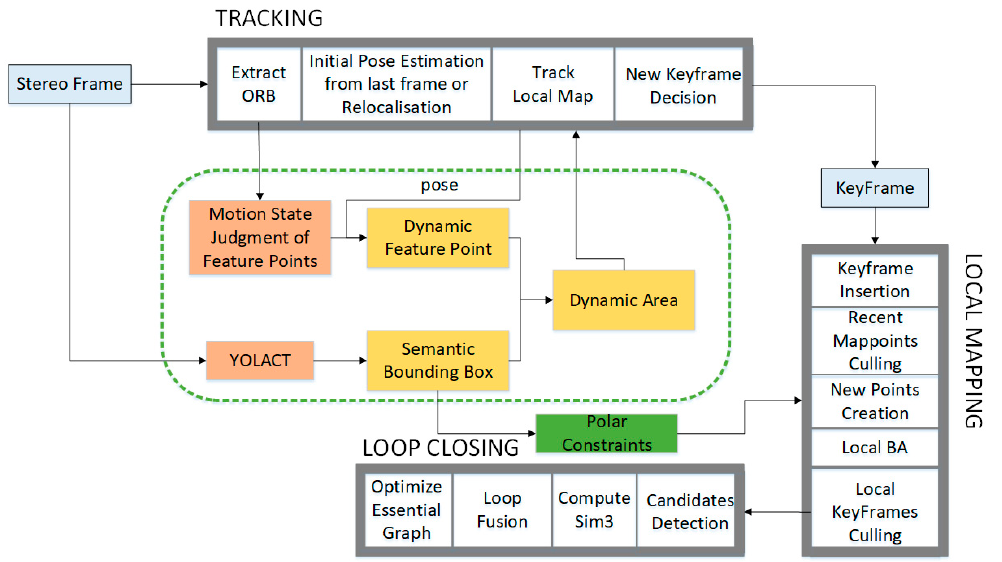
Figure 1. SVD-algorithmic SLAM framework. The gray box in the image represents the original portion of ORB-SLAM2, while the green box represents the dynamic feature point filtering portion that we added.